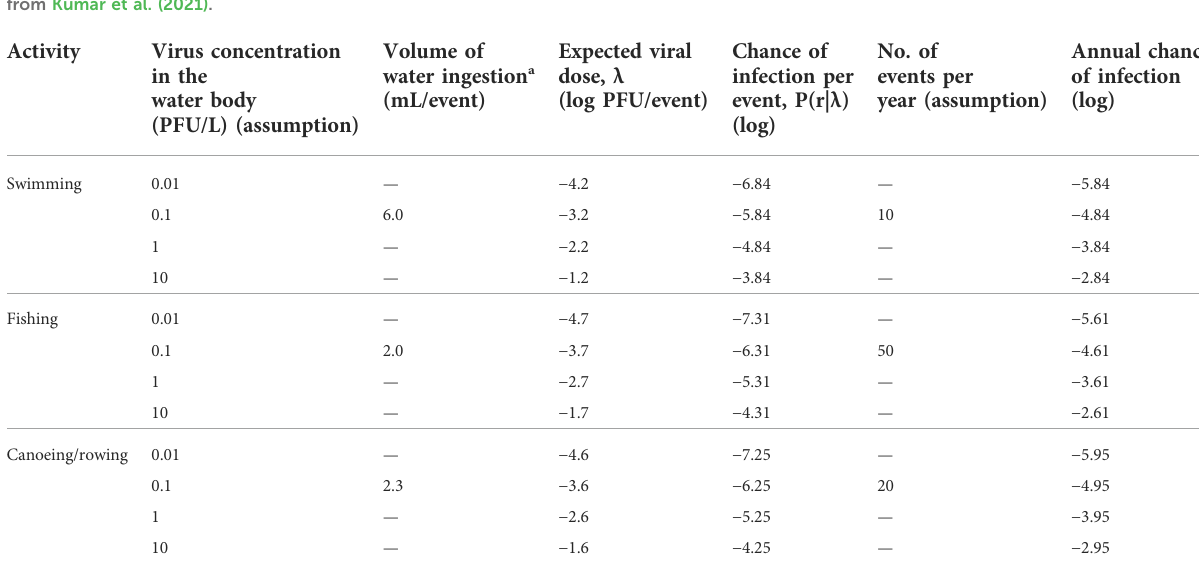
Annual chance of infection